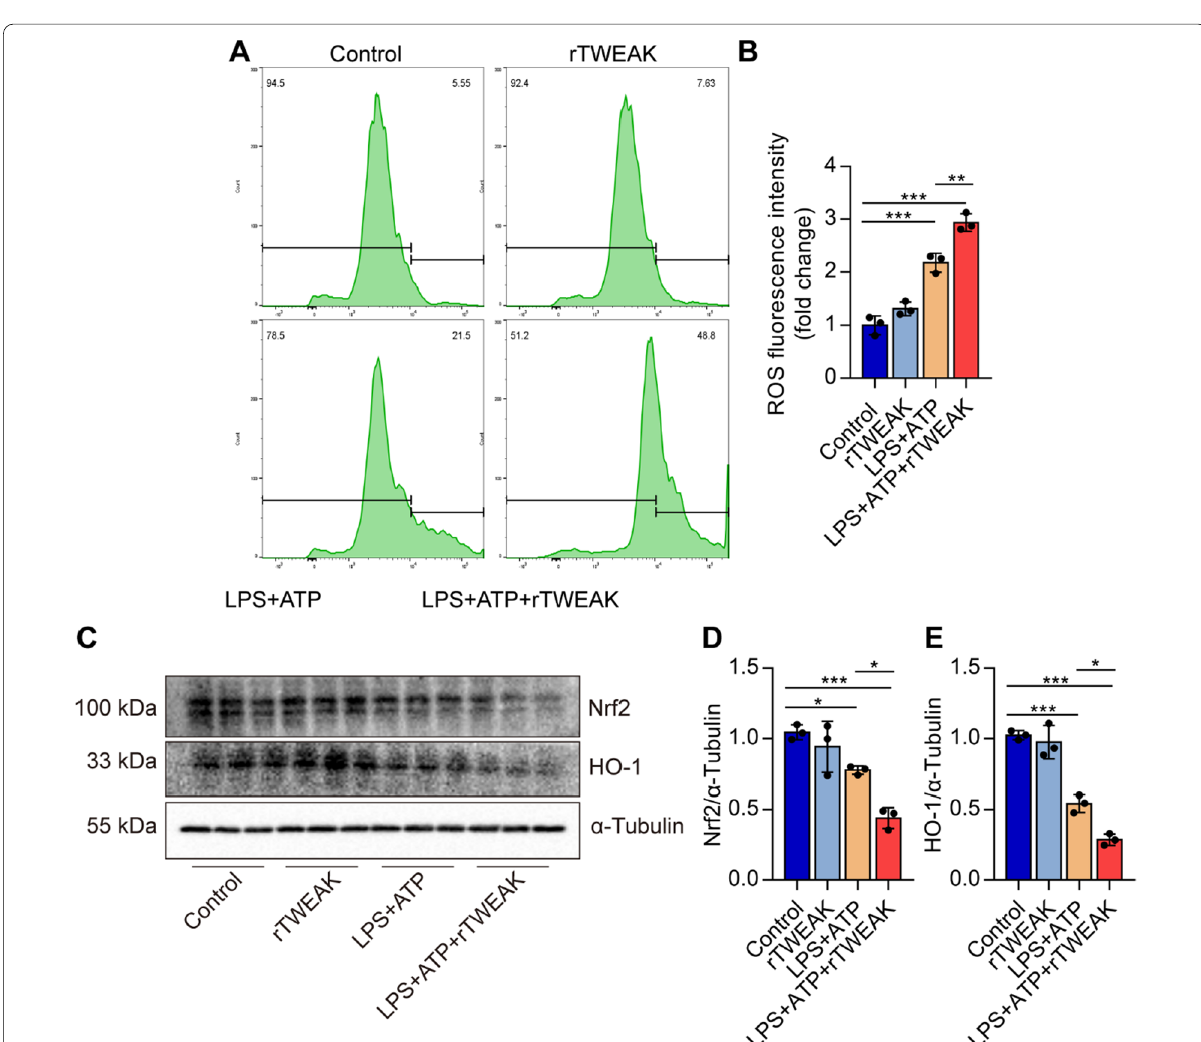
Fig. 9 Pre‑treated with rTWEAK aggravates the ROS production in macrophages. rTWEAK (100 ng/mL) was added to LPS (100 ng/mL) for 135 min and ATP (2.5 mM)‑challenged primary macrophages for 45 min. A , B ROS production in the primary macrophages was analyzed by the flow cytometry assay (